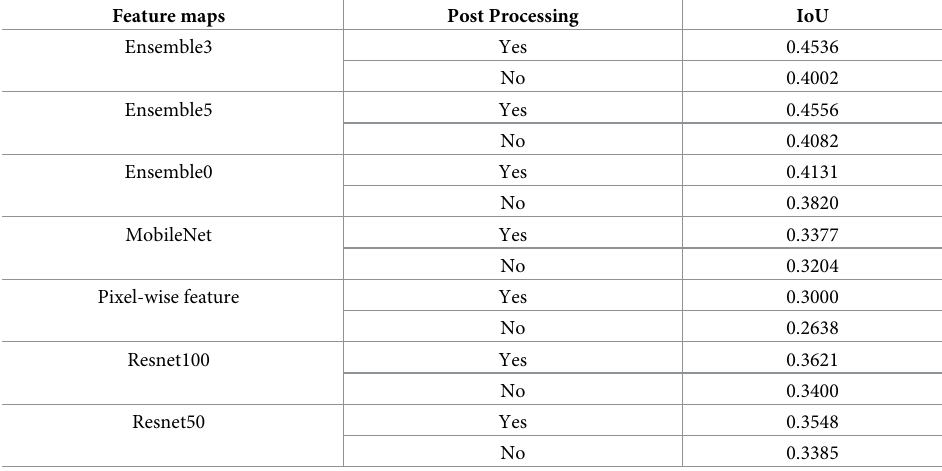
Table 3. The average IoU of feature maps and input blocks.